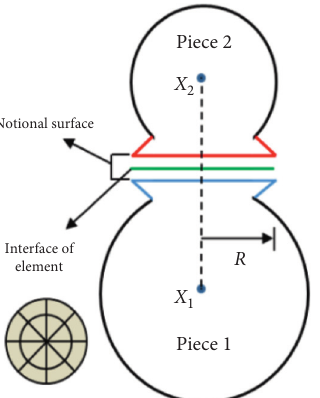
Figure 2: A typical schematic diagram of flat joint contact.